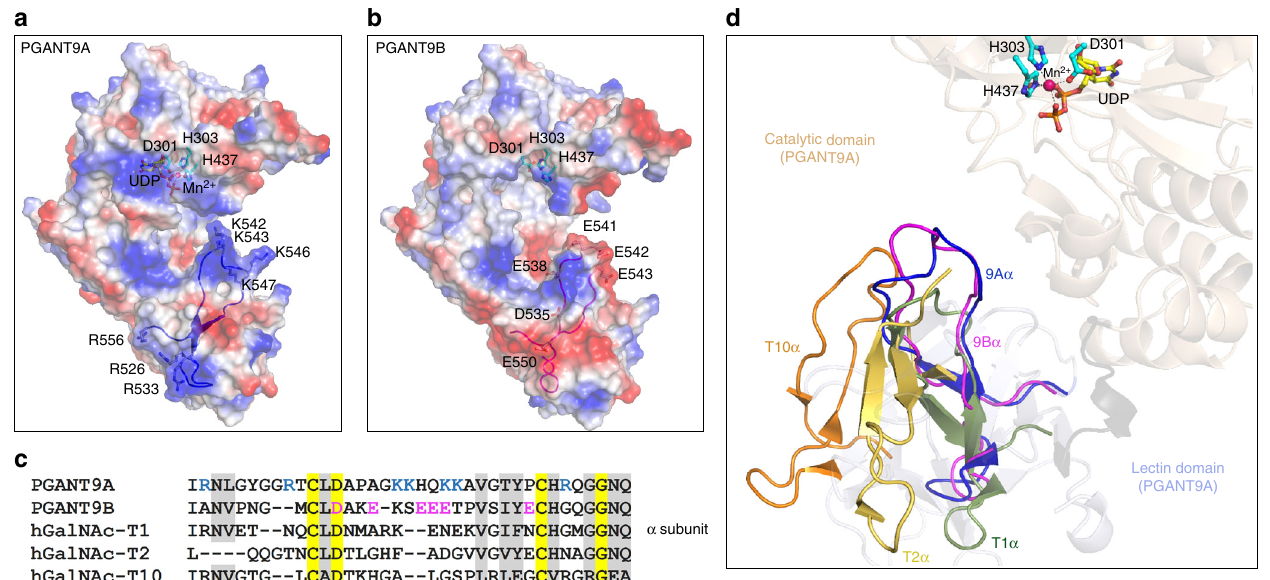
Fig. 6 The α subunits of PGANT9A and PGANT9B determine their unique substrate speci fi cities. a Electrostatic potential surface map of PGANT9A, where the blue regions are positively charged, and red regions are negatively charged superposed over the variable loop shown in dark blue. Basic residues in the loop are shown as sticks. b Electrostatic potential surface map of PGANT9B, where the blue regions are positively charged, and red regions are negatively charged superposed over the variable loop shown in magenta. Acidic residues in the loop are shown as sticks. c Sequence alignment of the α subunit of various isoforms. The α subunit is poorly conserved. Conserved residues are highlighted in yellow, and moderately conserved residues are highlighted in gray. The basic residues in PGANT9A are blue and the acidic residues in PGANT9B are in magenta. d The α subunits adopt distinct conformations. The α subunits of PGANT9A colored blue, PGANT9B colored magenta, ppGalNAc-T1 colored green, ppGalNAc-T2 colored yellow and ppGalNAc-T10 colored orange are superposed over the crystal structure of PGANT9A with the catalytic domain colored wheat, and the lectin domain colored light